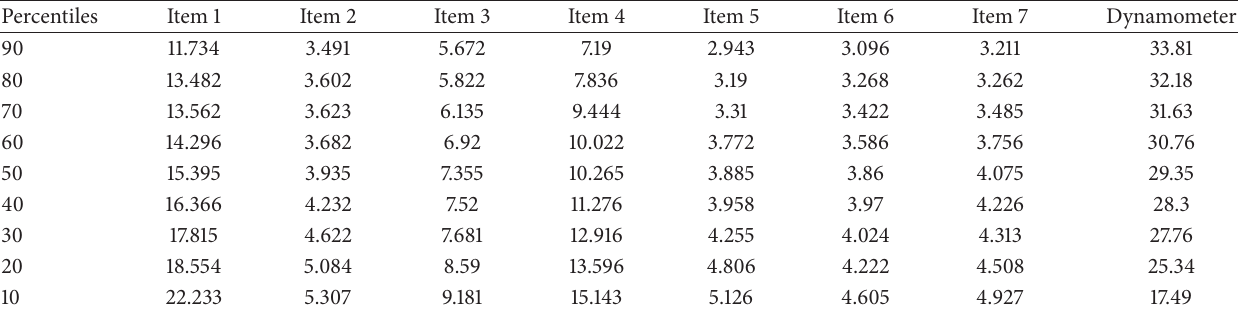
Table 16: 𝑛 = 16 , females, 6–19, dominant hand, educational instruction: attending elementary school.